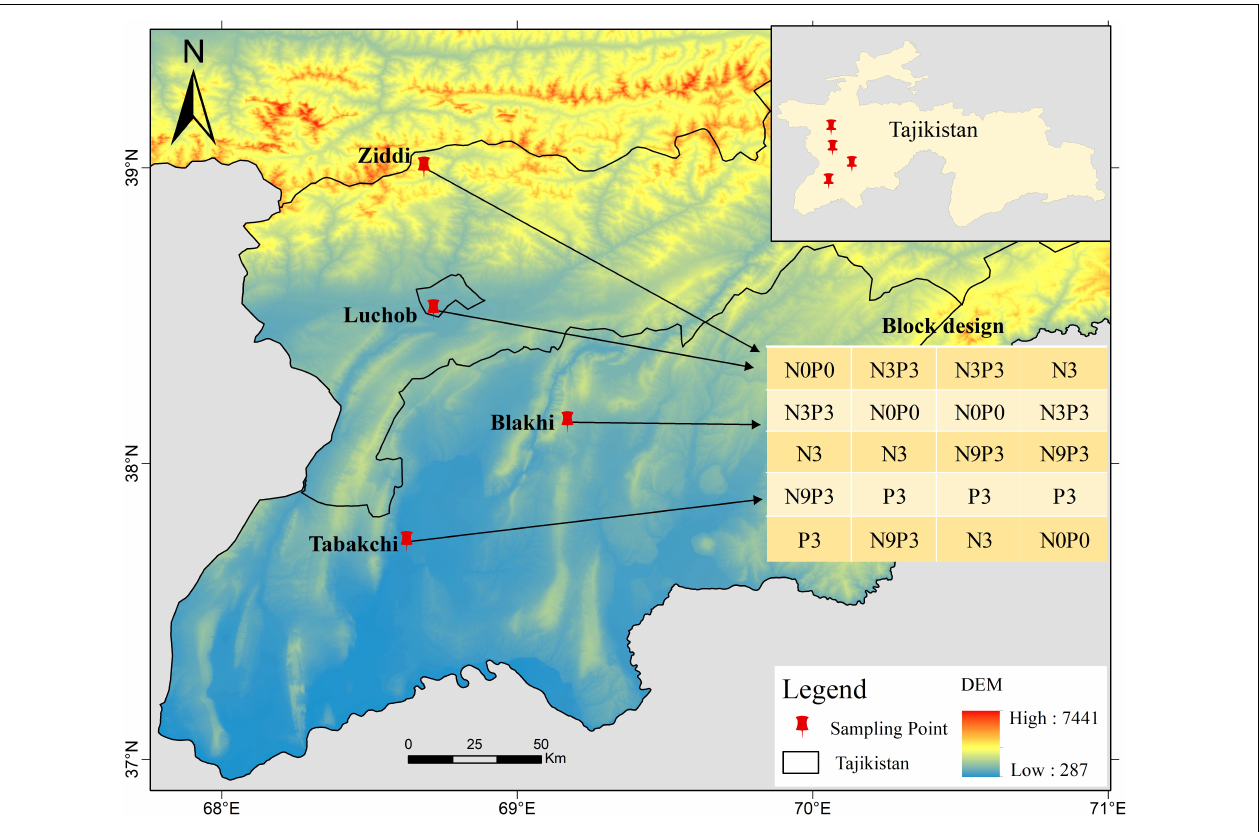
FIGURE 1 | Map of the study area and the experimental design. N0P0–the control; N3—addition of 30 kg N ha − 1 year − 1 , P3—addition of 30 kg P ha − 1 year − 1 , N3P3—addition of 30 kg N ha − 1 year − 1 and 30 kg P ha − 1 year − 1 , N9P3—addition of 90 kg N ha − 1 year − 1 and 30 kg P ha − 1 year − 1 . The fertilizer was added via a single application. The Shuttle Radar Topographic Mission (SRTM) 30 m digital elevation model (DEM) dataset was obtained from USGS